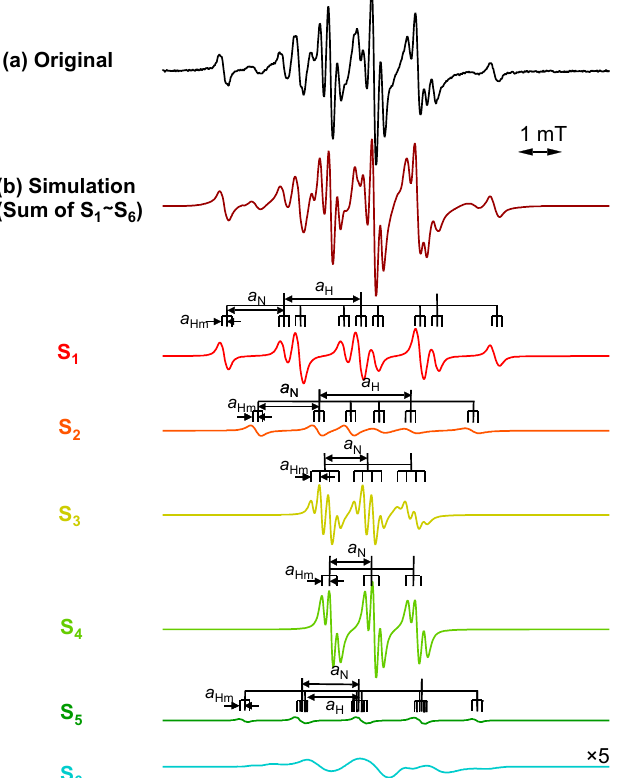
Figure 5. ( a ) ESR spectrum of PA66 with TTBNB observed at 160 ◦ C on stepwise heating, and ( b ) simulated spectrum using six spin adduct components, S 1 – S 6 . The parameters a Hm , a N , and a H are the hyperfine coupling constants ( hfcc ).